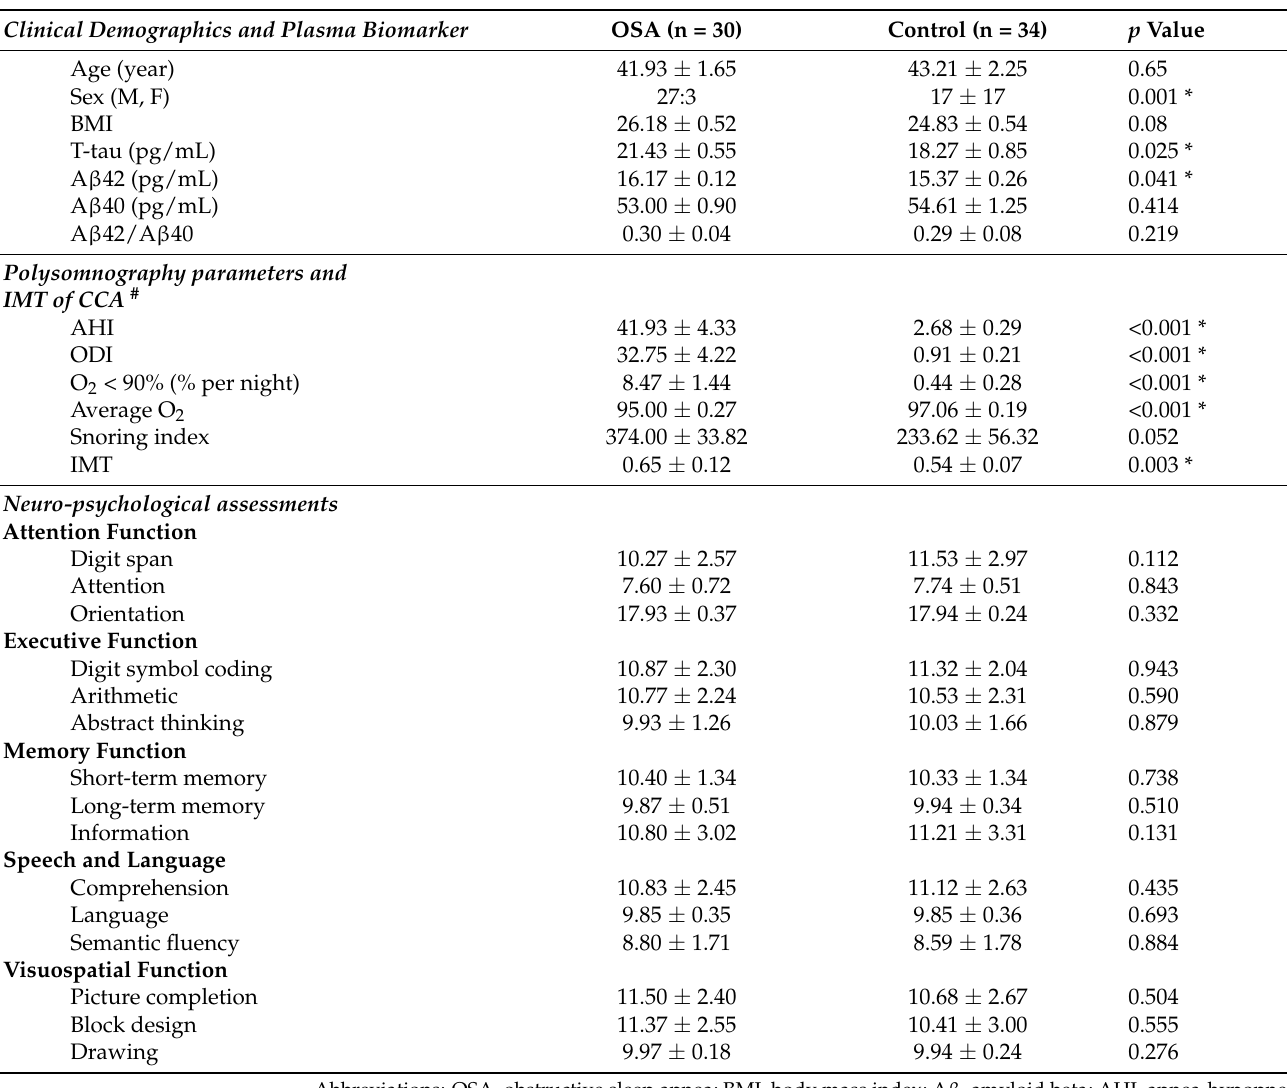
Table 1. Demographic data, plasma biomarker, clinical assessment, and neuro-psychological assess- ment data of patients with OSA and